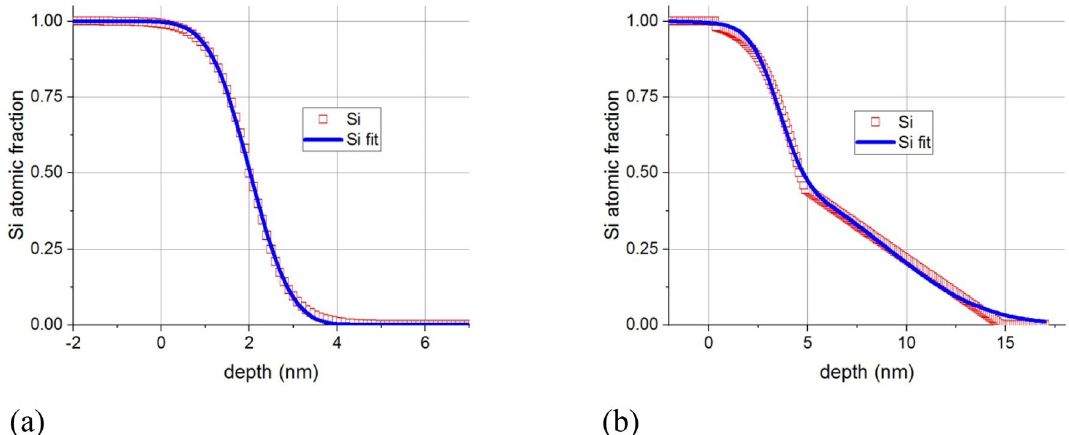
Figure 7. Fit of the composition profiles by erfc function to deduce the diffusion coefficients, for samples irradiated at 700 °C: ( a ) 5 nm Al 2 O 3 /Si substrate, ( b ) 20 nm Al 2 O 3 /Si substrate. Solid lines are the fitted